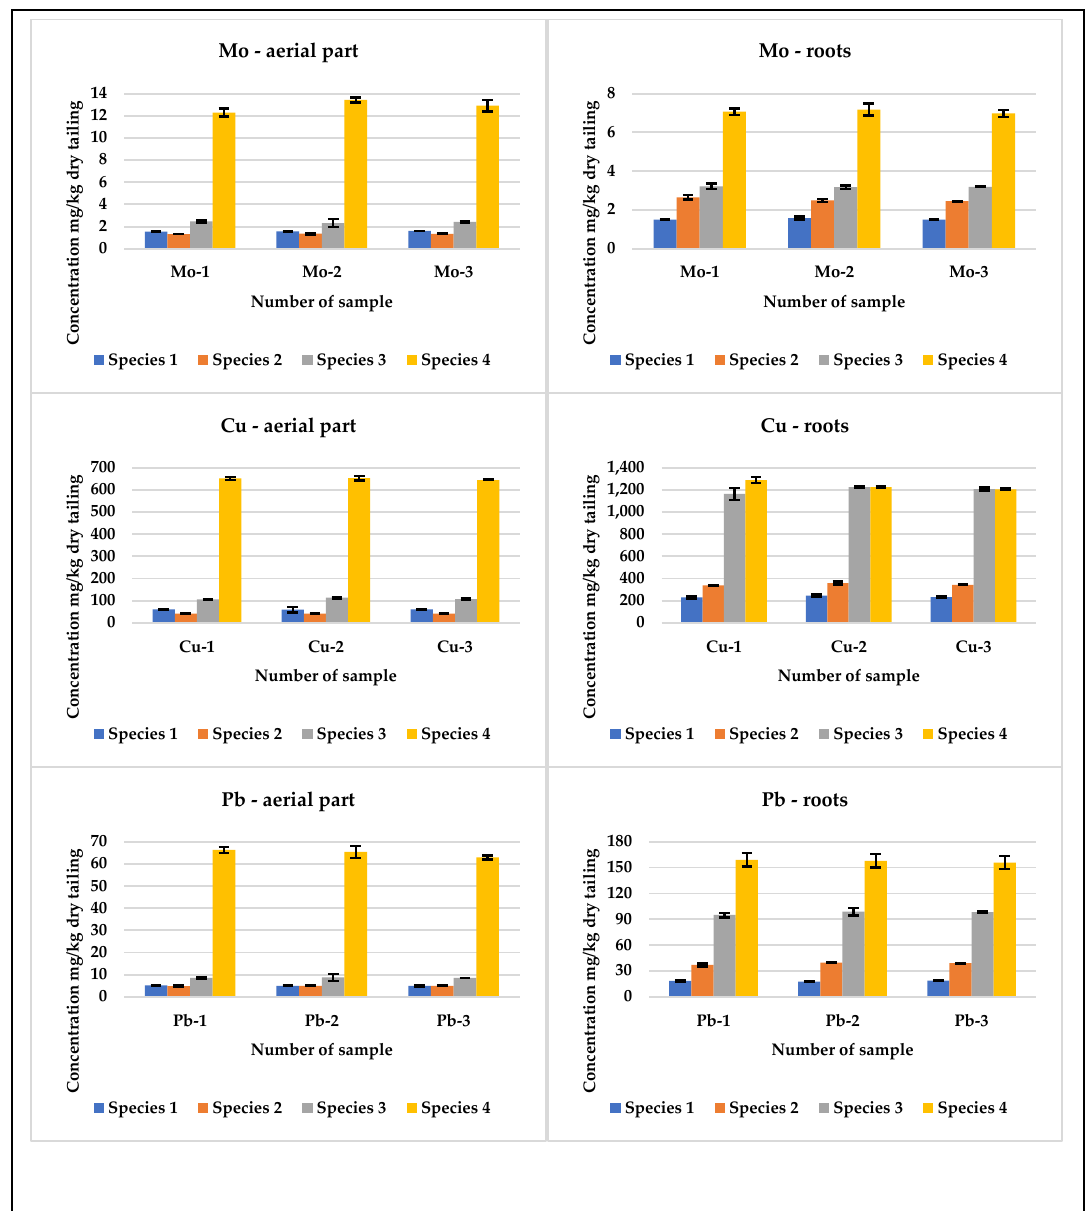
Figure 2. Mean concentration in duplicate samples, aerial part and roots, where species 1: Oxalis gigantea , species 2: Cistanthe grandiflora , Species 3: Puya berteroniana , species 4: Solidago chilensis .